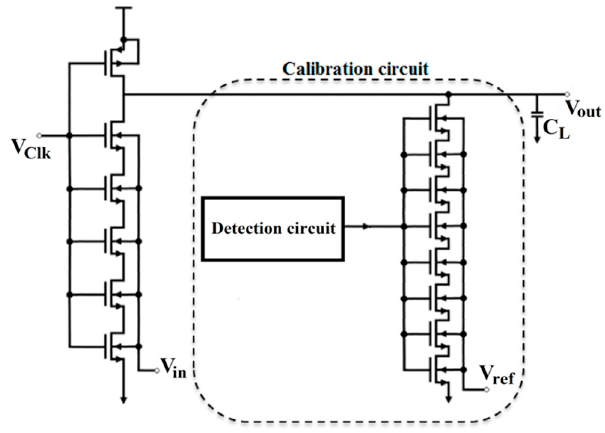
Figure 14. The first proposed VTC with the calibration circuit.